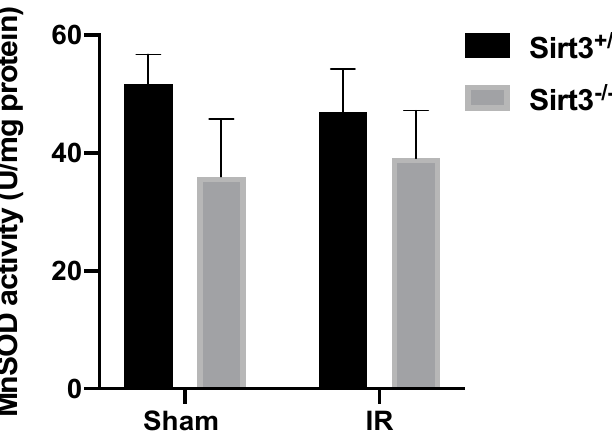
Figure 8. Exposure to 24 Gy liver only irradiation did not significantly alter enzymatic activity of MnSOD in Sirt3 +/+ or Sirt3 − / − mice ( n = 4–6).